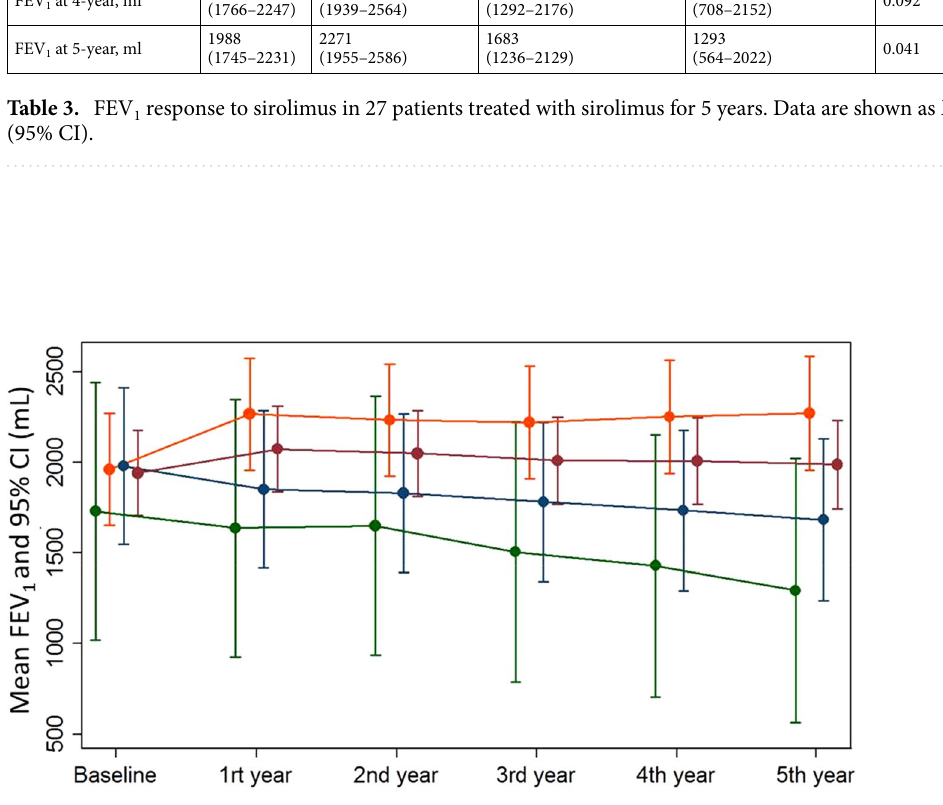
Figure 4. Linear prediction of longitudinal changes in FEV 1 (ml) and predictive margins with 95% CI using mixed effect models, in all patients (red), responders (yellow), partial responders (blue) and non-responders